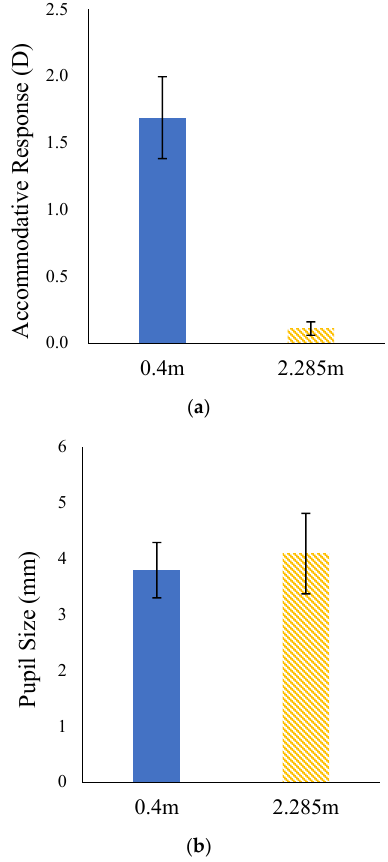
Figure 4. Comparison of ( a ) accommodative response and ( b ) pupil size at the two viewing distances of 0.4 m and 2.285 m.